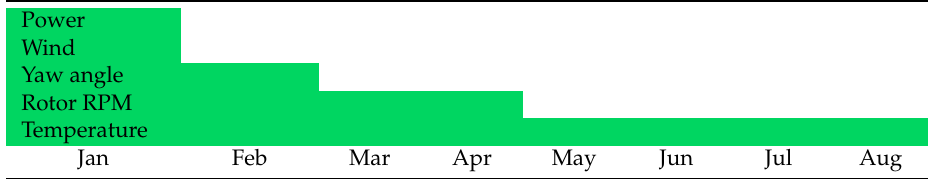
Table 3. Minimum necessary training lengths for capturing the complete SCADA data value